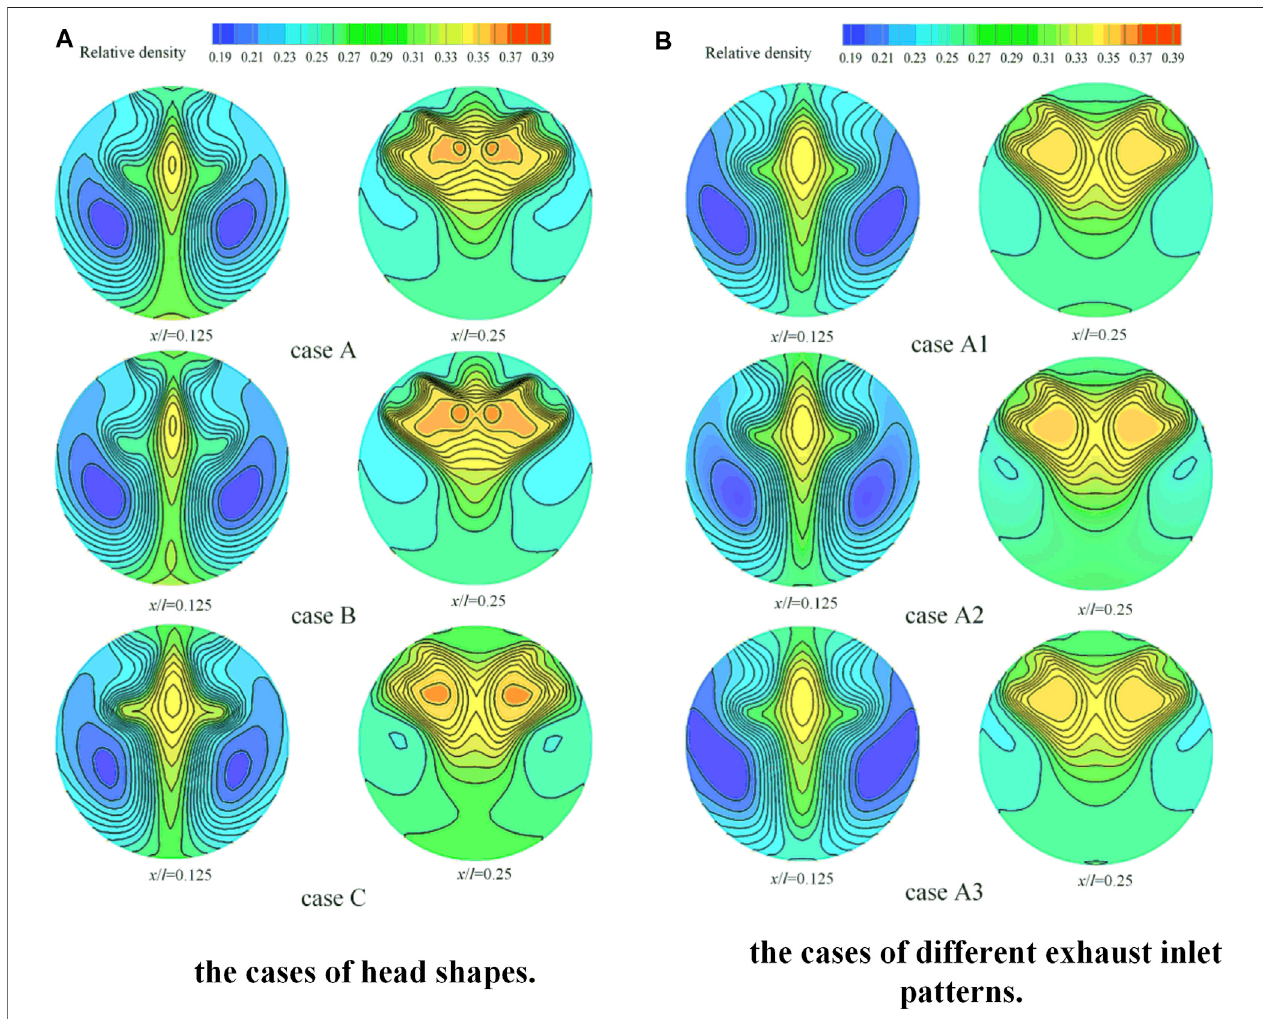
FIGURE9| Contoursofrelativedensityofthemixingexhaust/airontwo y-z sections( x / l (cid:2) 0.125and x (cid:2) 0.25)forallthecases:(a)thecasesofheadshapes(caseA, case B, and case C); (b) the cases of different inlet patterns (case A1, case A2, and case A3).